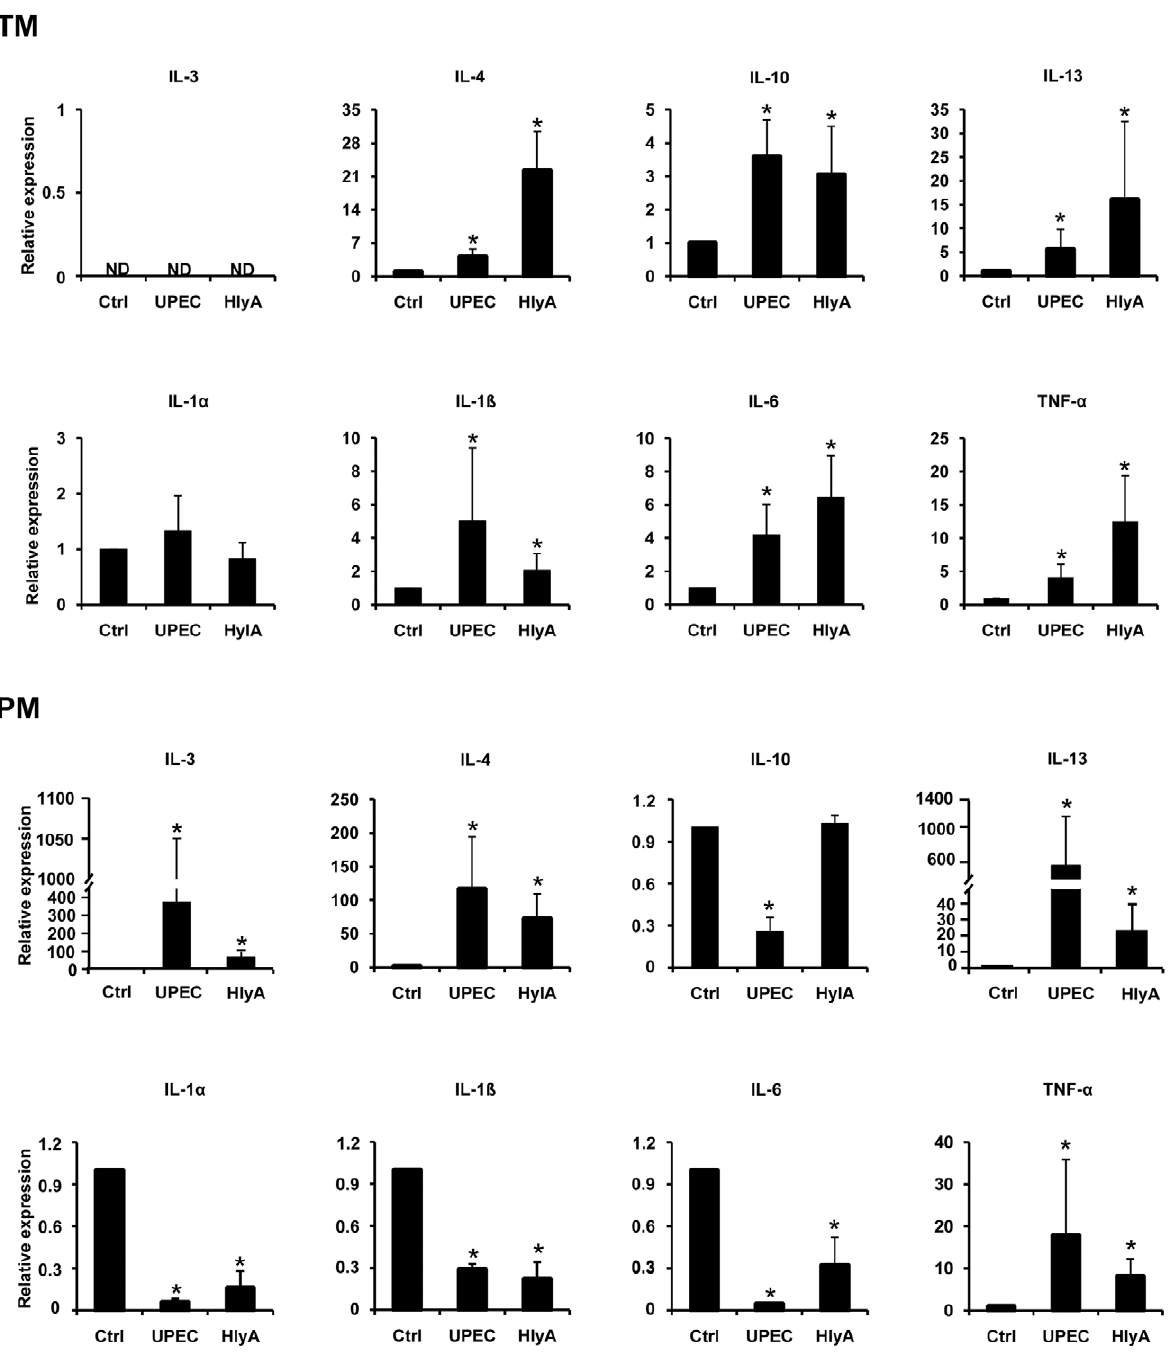
Figure 6. qRT-PCR analyses of anti-inflammatory cytokines (IL-3, IL-4, IL-10, IL-13, upper row) and pro-inflammatory cytokines (IL1- a , IL1- b , IL-6, TNF- a , lower row) after challenge of TM and PM with UPEC CFT073 (MOI=20) or hemolysin A (HlyA, 40 ng/ml) for 1 h. Results were normalized using b -microglobulin and b -actin as endogenous controls and are shown as fold changes relative to uninfected controls. HlyA was preincubated with polymyxin B (50 m g/ml) at 4 u C for 30 min to remove any possible LPS contamination. Values are means 6 SD of triplicates. Mann-Whitney U test was used to analyze data and p # 0.05 was considered significant.